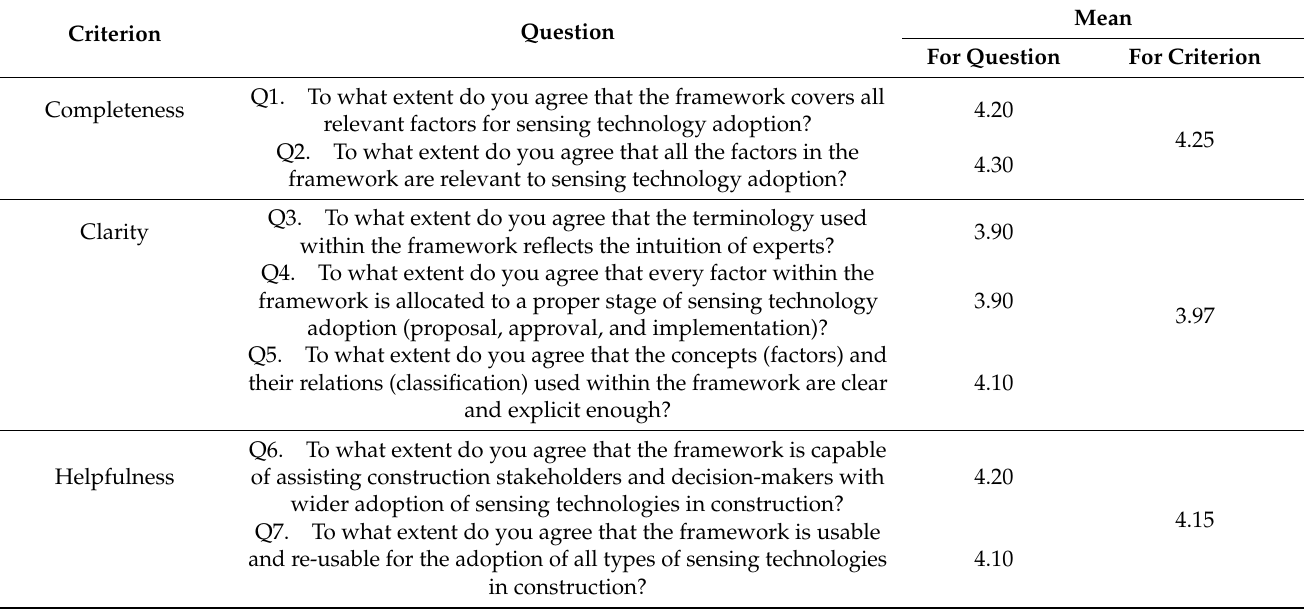
Table 9. Rank of validation questions and the associated